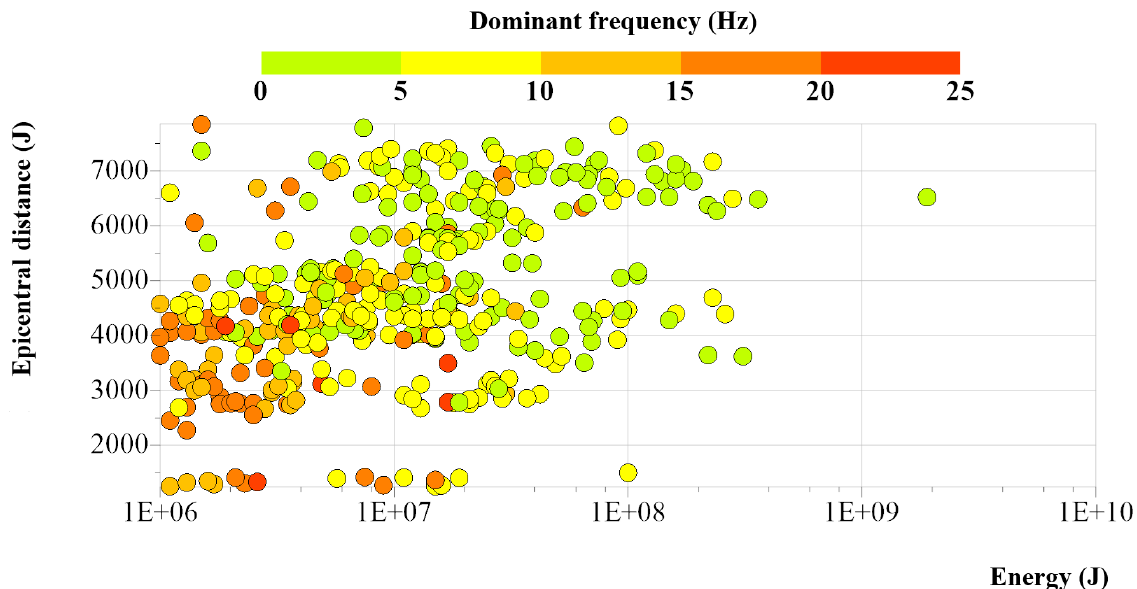
Figure 2: The dominant frequency content of LGCB mining-induced tremors in relation to their epicentral distance and energy (over 430 entries, vertical and horizontal components were